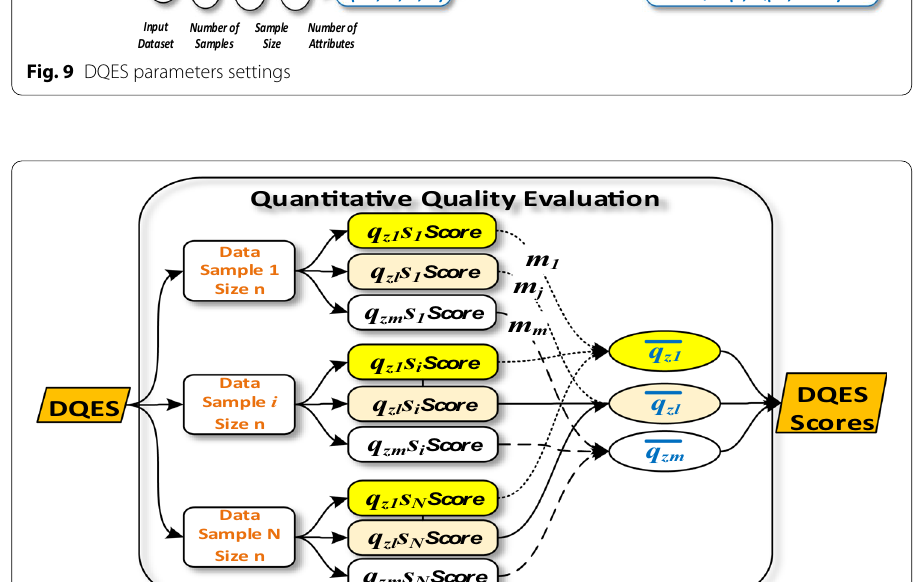
Fig. 10 Big data sampling and quantitative quality